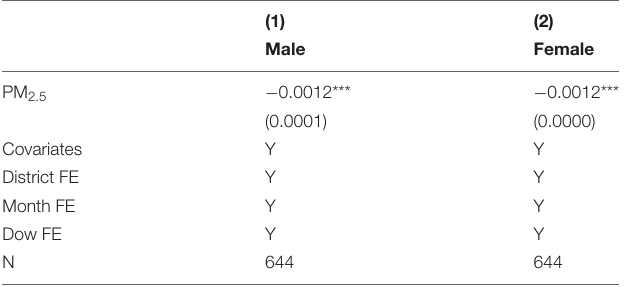
TABLE 6 | Heterogeneous relationship in different gender.